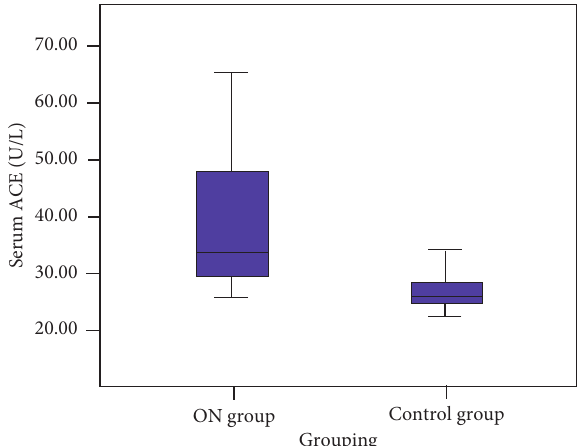
Figure 1: Median serum ACE level was higher in the ON patients than in the control group.